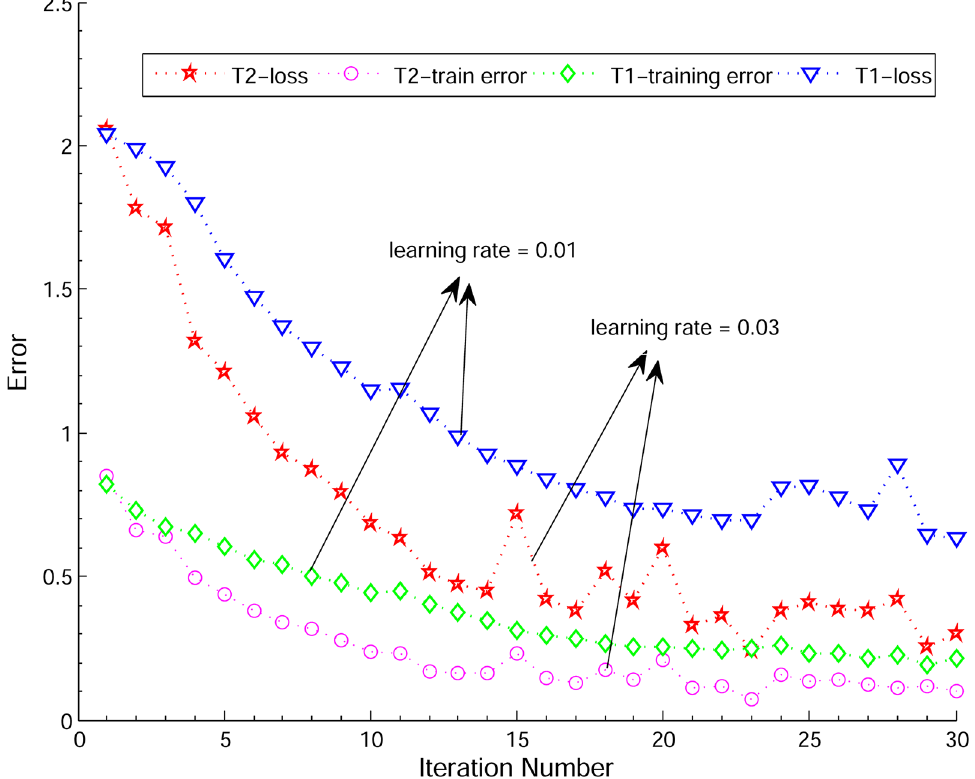
Fig 9. Convergence studies on loss and train error with respect to the number of iterations and different learning rate settings.